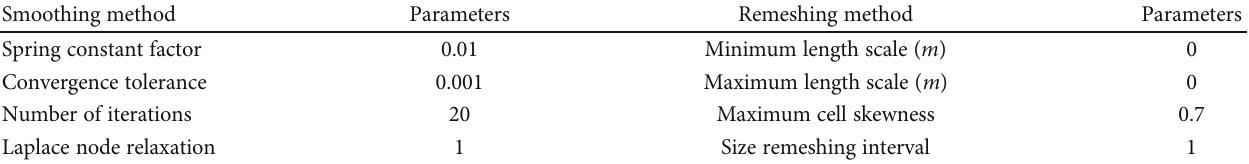
Table 2: Settings of the dynamic